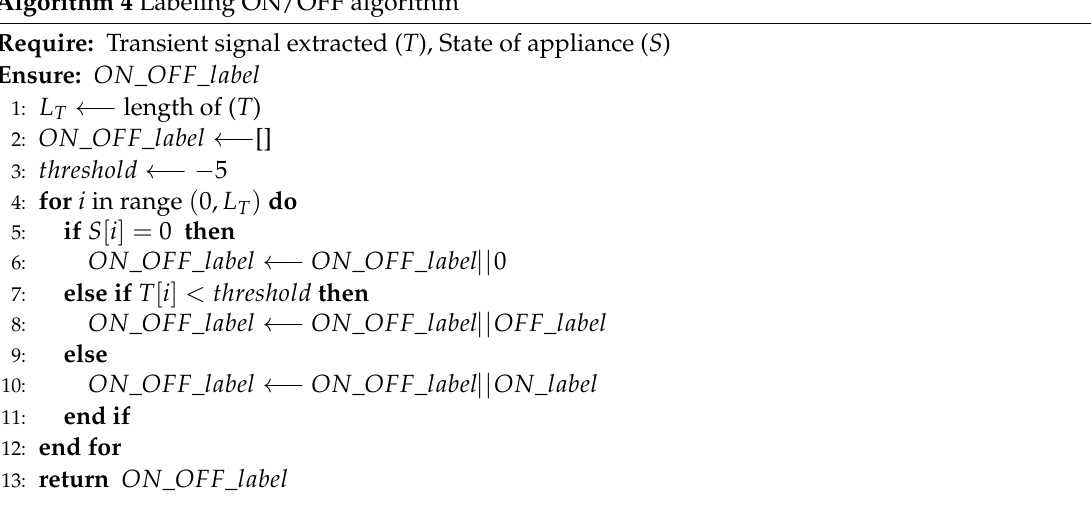
Algorithm 4 Labeling ON/OFF